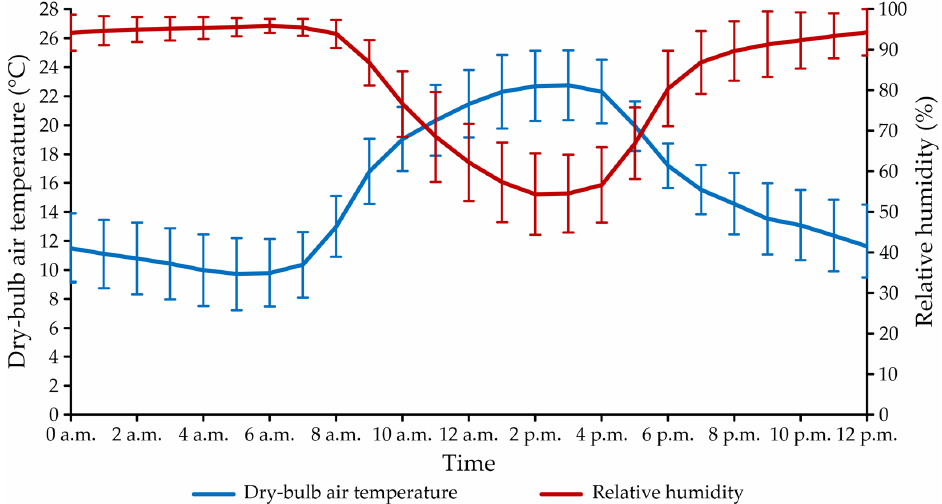
Figure 2. Curves of average hourly values, with standard deviation, of dry-bulb air temperature, and relative humidity throughout the day inside the CBP facility.